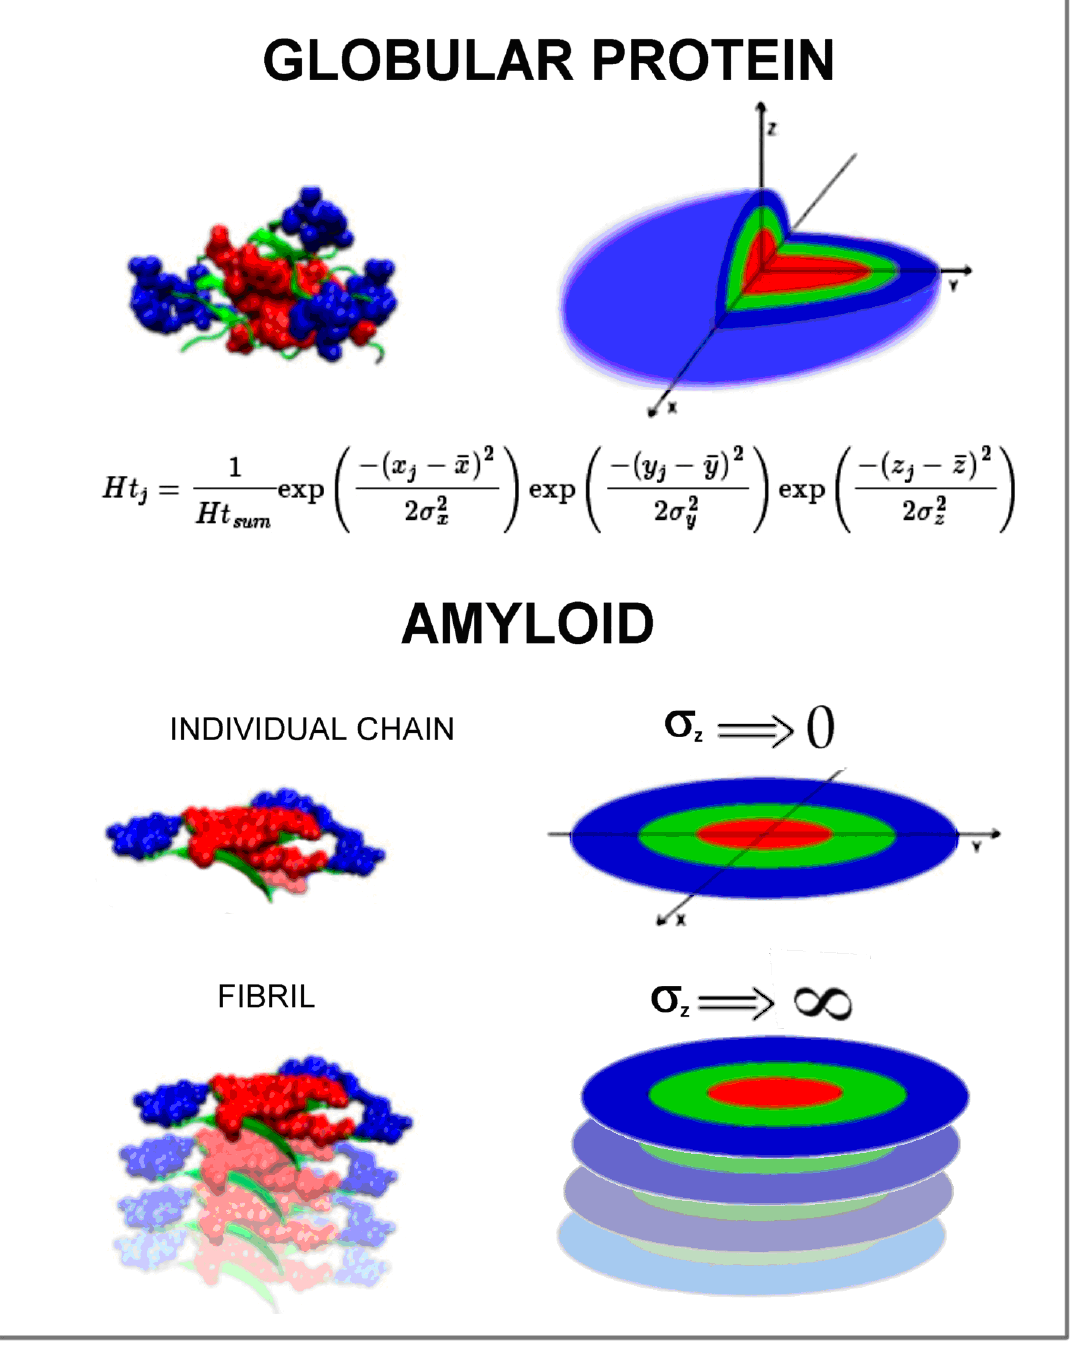
Figure 5. The visualization of hydrophobicity distribution expressed by a 3D Gaussian function in globular protein in comparison to the status appearing in an individual polypeptide chain in amyloid form expressed by the 2D Gaussian function. The manipulation of the σ Z parameter seems to be critical for the simulation of amyloidosis transformation in silico.